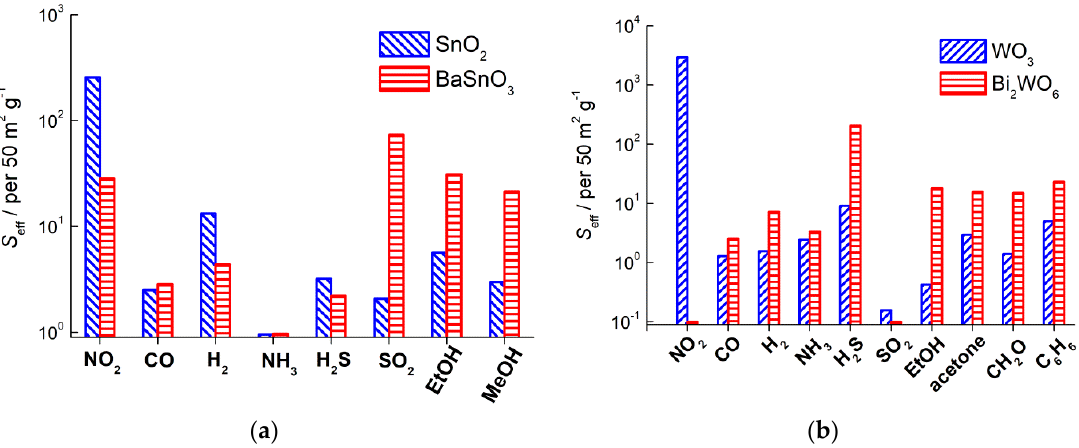
Figure 21. Sensitivity of nanocrystalline SnO 2 and BaSnO 3 to NO 2 (2 ppm) at 100 °C, CO (50 ppm), NH 3 (20 ppm), H 2 S (2 ppm), H 2 (100 ppm), SO 2 (10 ppm), ethanol (20 ppm), methanol (20 ppm) at 300 °C ( a ) [77]; and sensitivity of nanocrystalline WO 3 and Bi 2 WO 6 to NO 2 (1 ppm) at 100 °C, ethanol (20 ppm) at 150 °C, SO 2 (2 ppm), formaldehyde (400 ppb), H 2 S (2 ppm) at 250 °C, CO (20 ppm), H 2 (50 ppm), NH 3 (20 ppm), acetone (2 ppm), benzene (2 ppm) at 300 °C ( b ) [63].